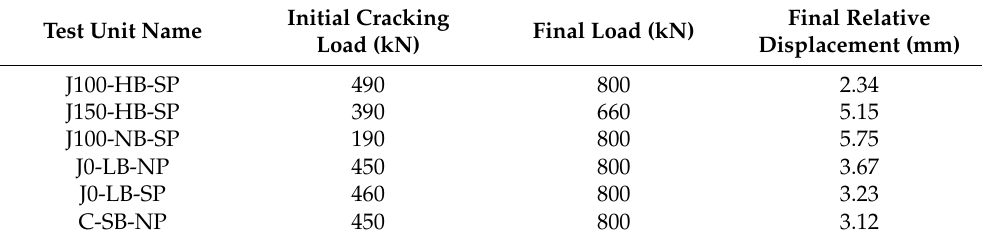
Table 2. Test results.